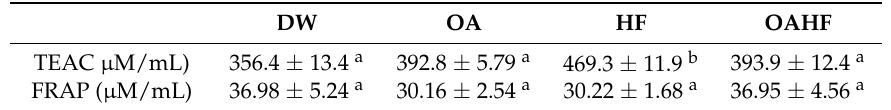
Table 5. The effects of neonatal oral administration of oleanolic acid on the antioxidant capacity in the skeletal muscles of suckling male and female